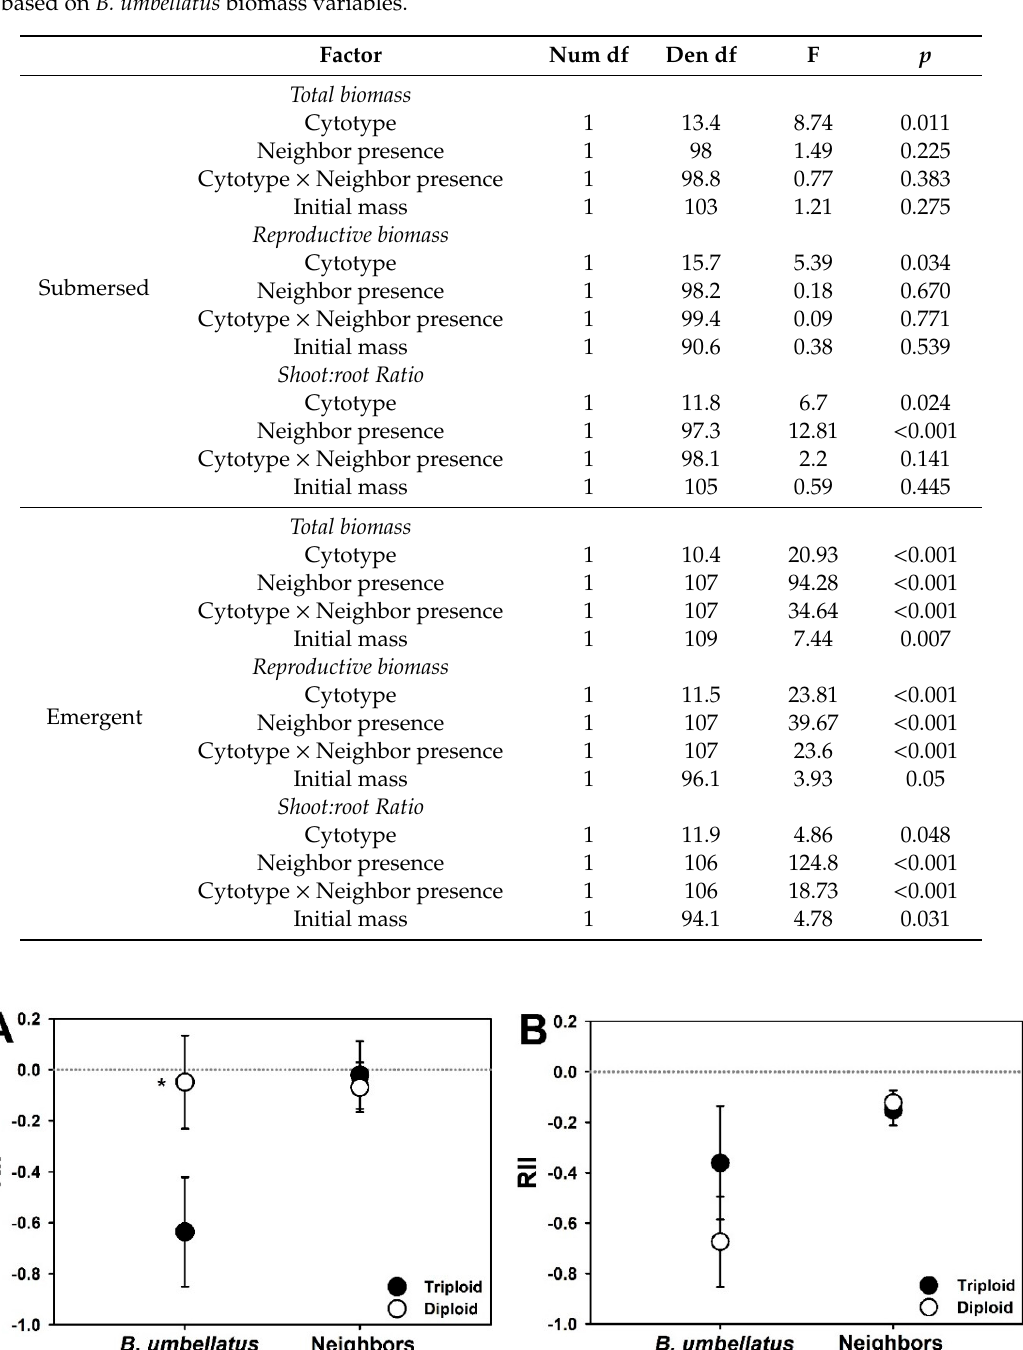
Table 2. ANOVA results for submersed and emergent competition experiments with B. umbellatus, based on B. umbellatus biomass variables.